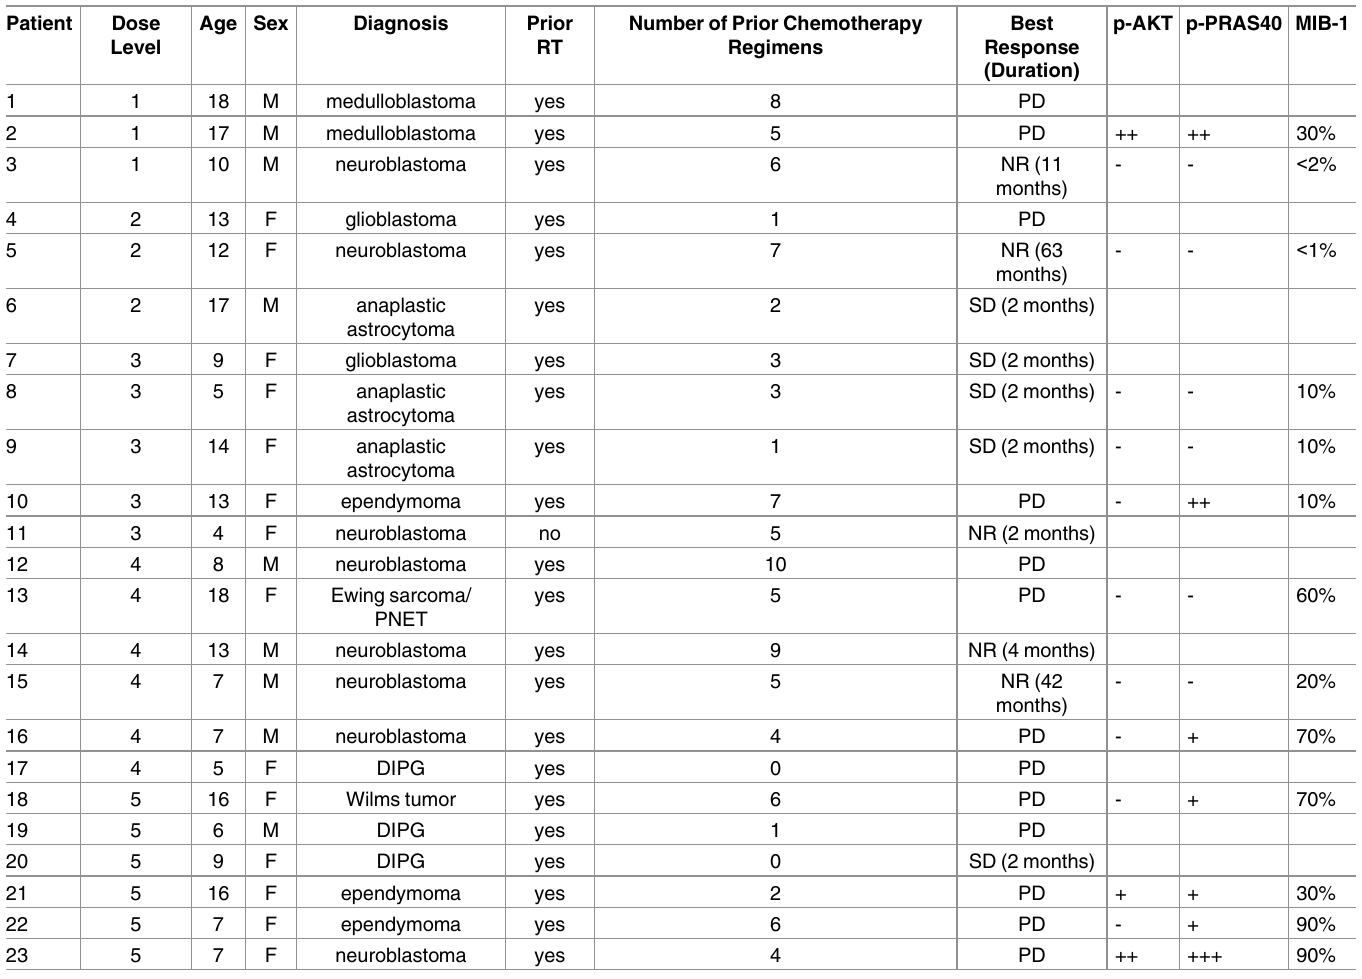
Table 6. Patient characteristics and